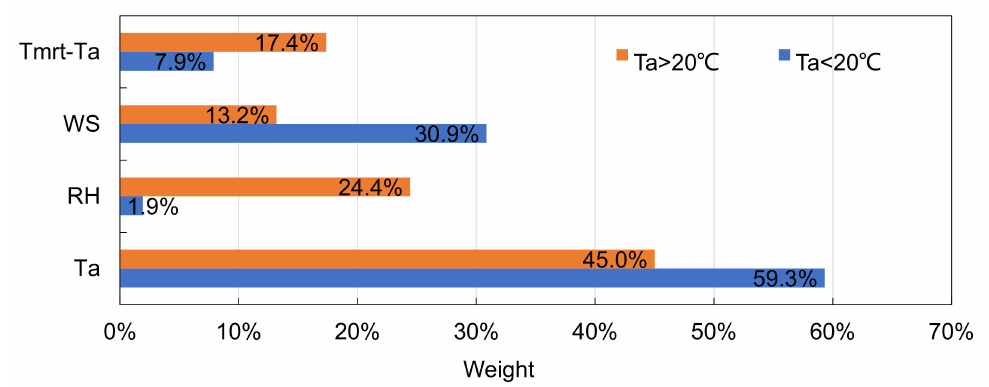
Figure 6. Weights of different thermal environment parameters on attendance of optional activities when air temperature was above or below 20 ◦ C.